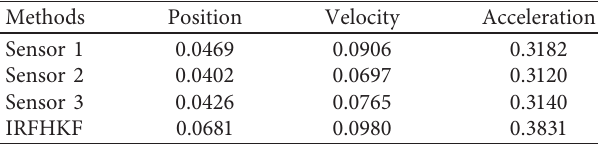
Figure 7: Comparing DWFASS and IRFHKF methods: (a) trace for the upper boundary, (b) comparison of the estimated position state, (c) comparison of the estimated velocity state, (d) comparison of the estimated acceleration state, and (e) comparison of MAEs for the position. Table 1: Comparing RMSEs between DWFASS and